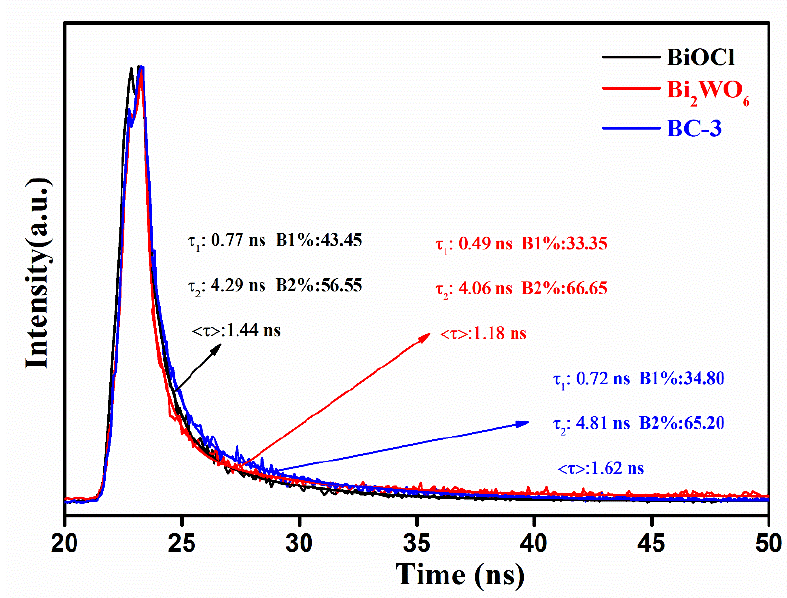
2 WO 6 , and Bi 2 WO 6 /BiOCl